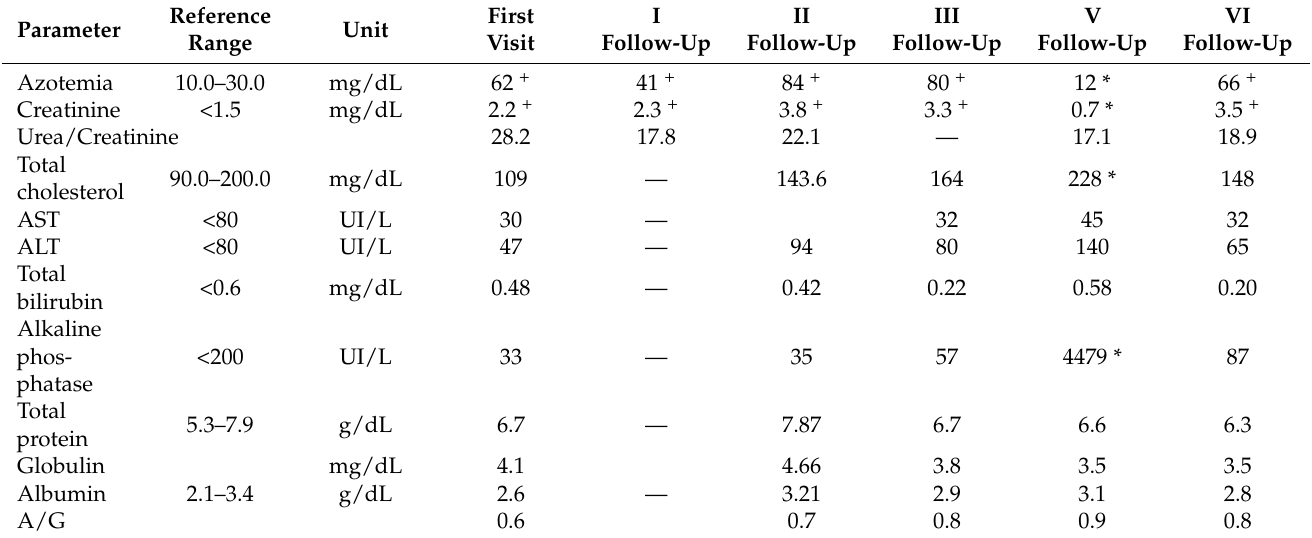
Table 2. Biochemistry analyses of the leishmaniotic cat during the study period. (AST = aspar- tate aminotransferase; ALT = alanine amino-transferase; A/G = albumin and globulin ratio); + /*, increasing and decreasing values.